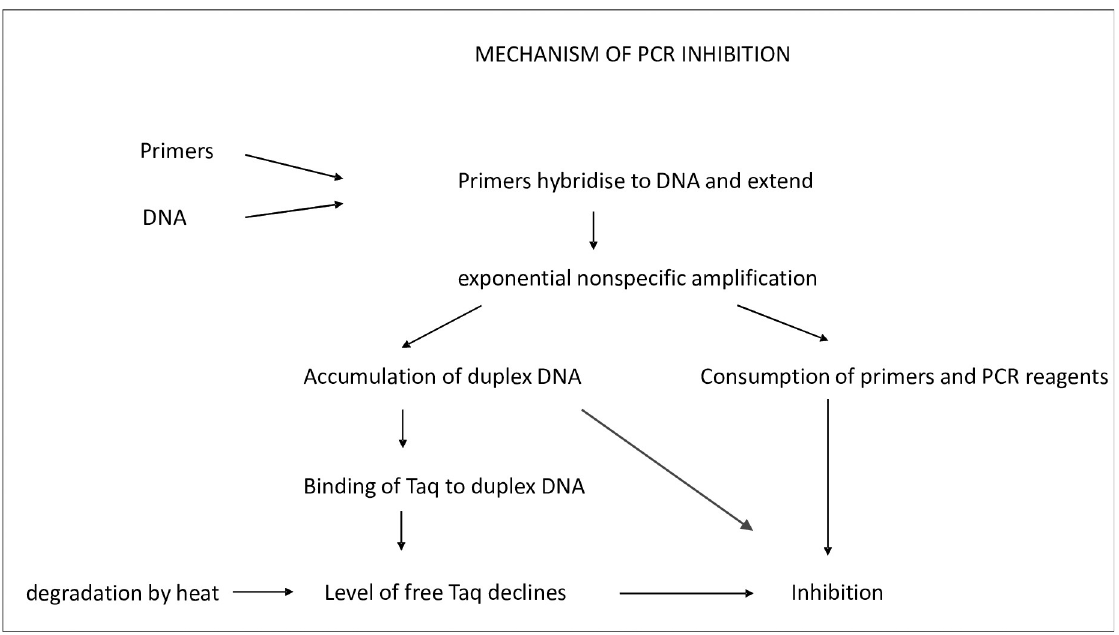
Fig 5. Proposed mechanism of inhibition of the PCR by genomic